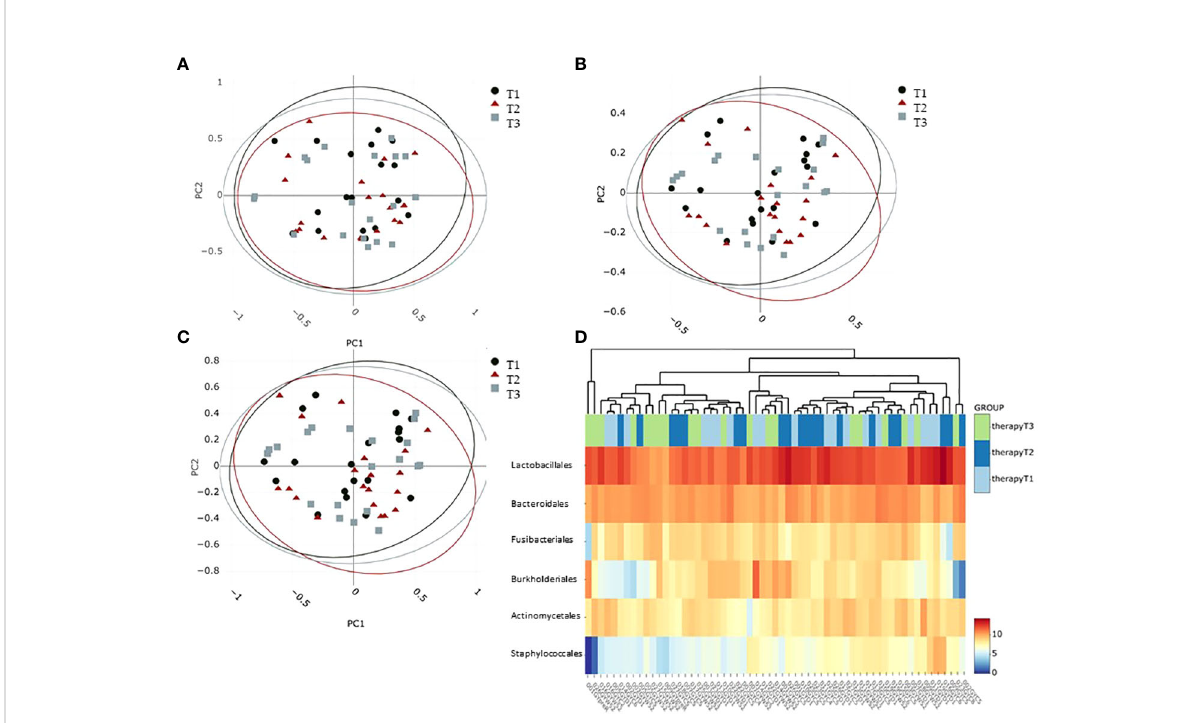
FIGURE 3 Beta diversity calculations at phylum level characterizing the intersample difference: (A) Chao, (B) Bray – Curtis as well as (C) Jaccard indices. Con fi dence ellipses indicate a 95% con fi dence level. (D) Abundance heatmap plotting to visualize hierarchical clustering on the six most dominant taxa at the order level. Colors from blue to red indicate feature abundance in the log scale. T1: before/at start of chemotherapy, T2: 12 weeks after the onset of chemotherapy, T3: 52 weeks after the onset of chemotherapy.